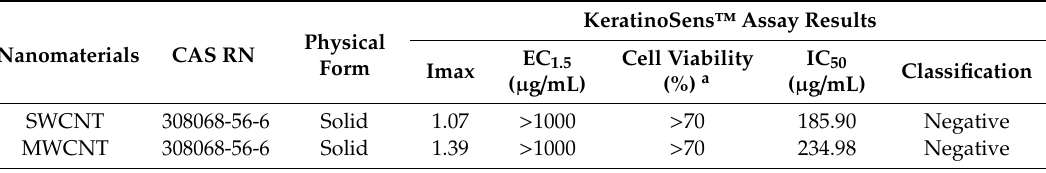
Table 2. SWCNTs and MWCNTs evaluated in KeratinoSens ™